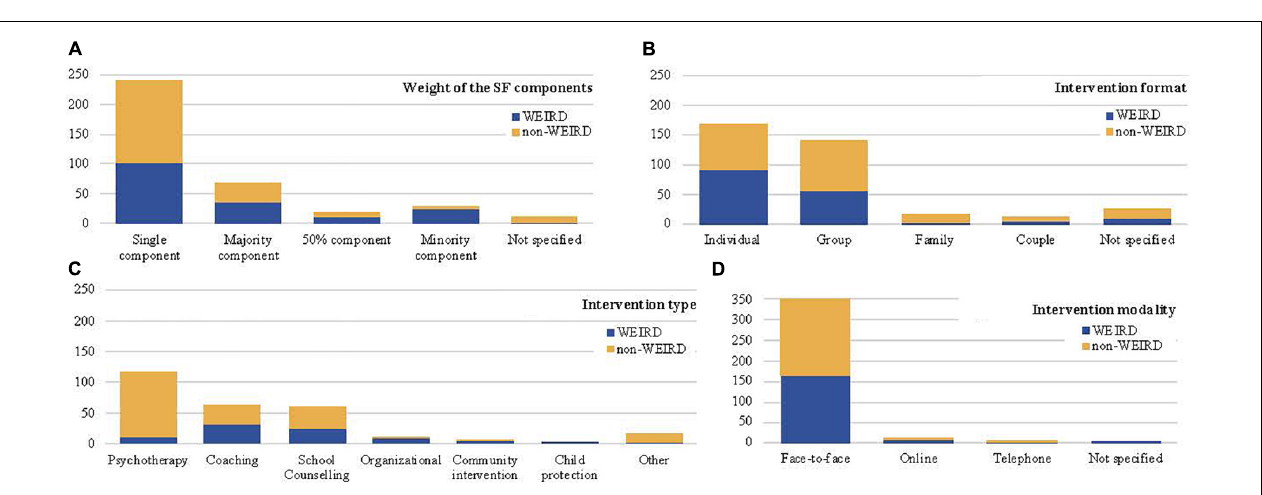
FIGURE 5 | Comparison of SFBT features between WEIRD and non-WEIRD countries. (A) Weight of the SF components. (B) Intervention format. (C) Intervention type. (D) Intervention